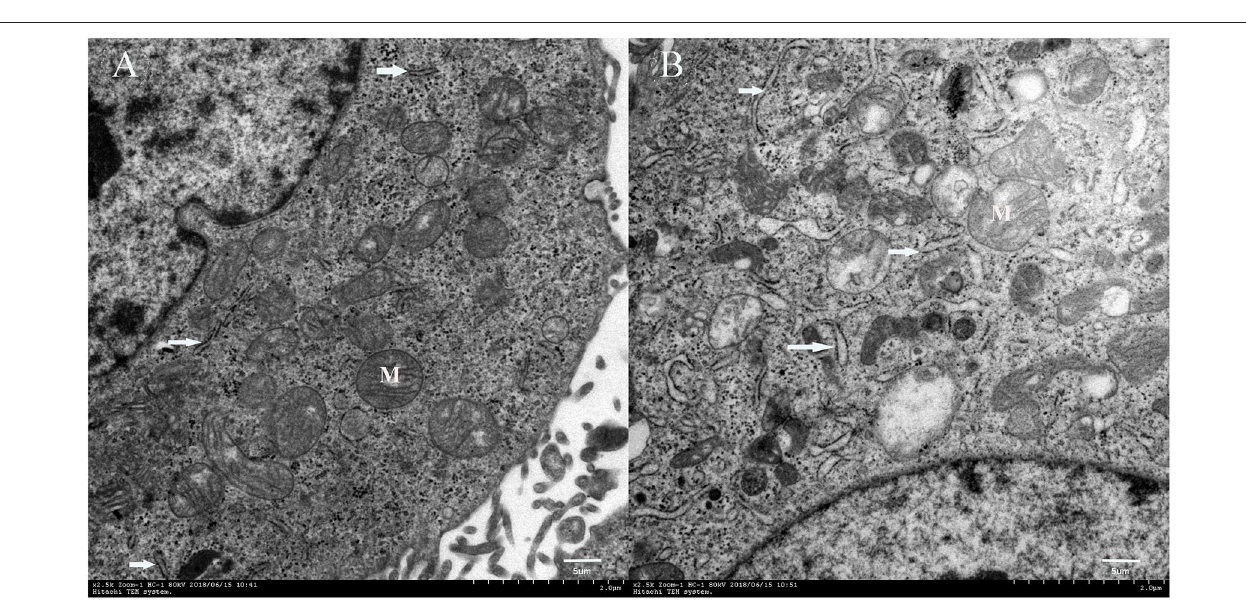
the cosmic radiation (7). Moreover, the terrestrial radiation in DUGL (0.04 µ Sv/h) was significantly lower than that in